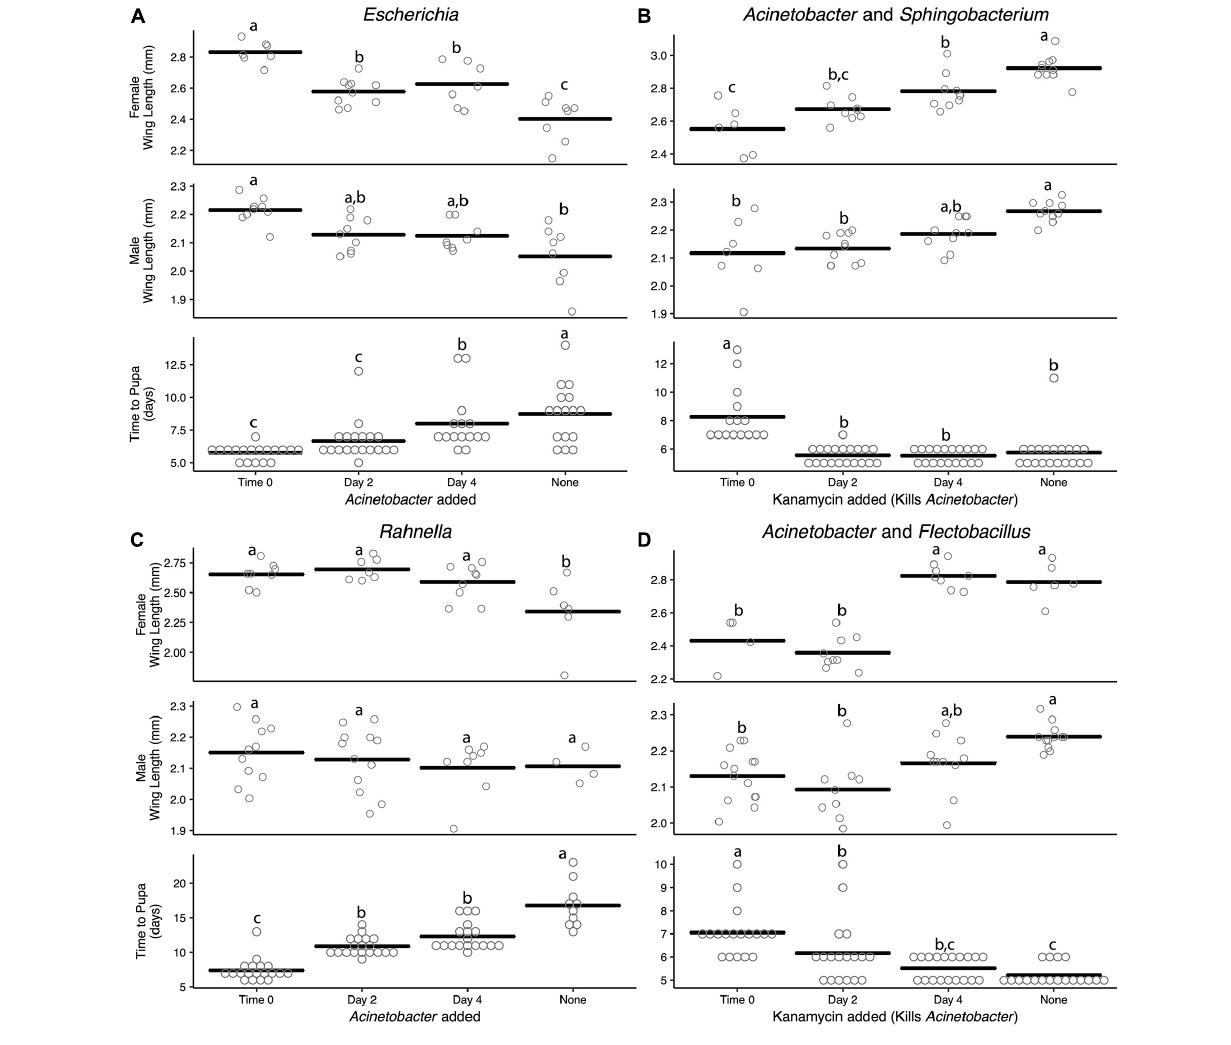
FIGURE 3 | Addition or removal of a second bacterial species during development alters adult size and time to pupa. Acinetobacter was added to (A) Escherichia or (C) Rahnella or removed with kanamycin from (B) Sphingobacterium or (D) Flectobacillus . All experiments were conducted using FF diet. Bars indicate mean abundance for the treatment and significance level assigned by ANOVA with Tukey’s HSD for wing length and Steel–Dwass test for pupation